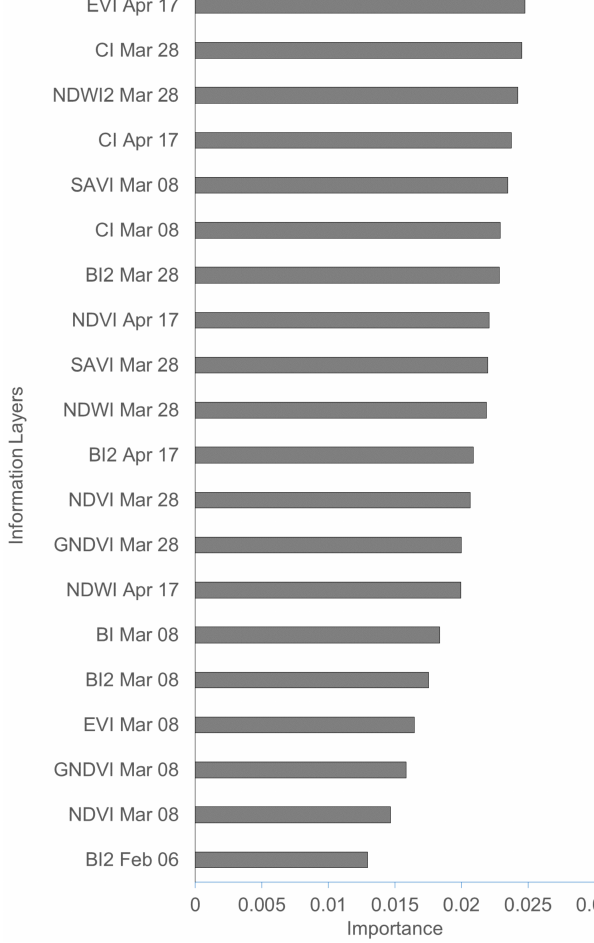
Figure 8. Relative importance scores of the top 20 index by image acquisition date combinations used for the identification of the crops by mid-April with a random tree algorithm. Imagery acquired on 4 dates between February 6 and mid-April, 2019 was used to calculate 9 indices, resulting in 36 data layers. Layers labeled with an acquisition date of April 17 are based on the median of cloud-free pixels acquired on April 7, 17 and